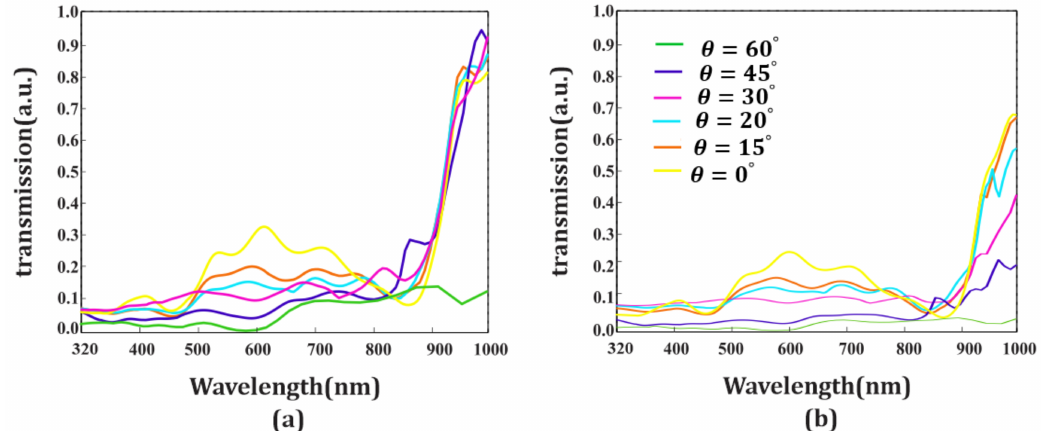
Figure 12. Transmission spectra for inclined radiation for ( a ) bare cell ( b ) proposed cell.